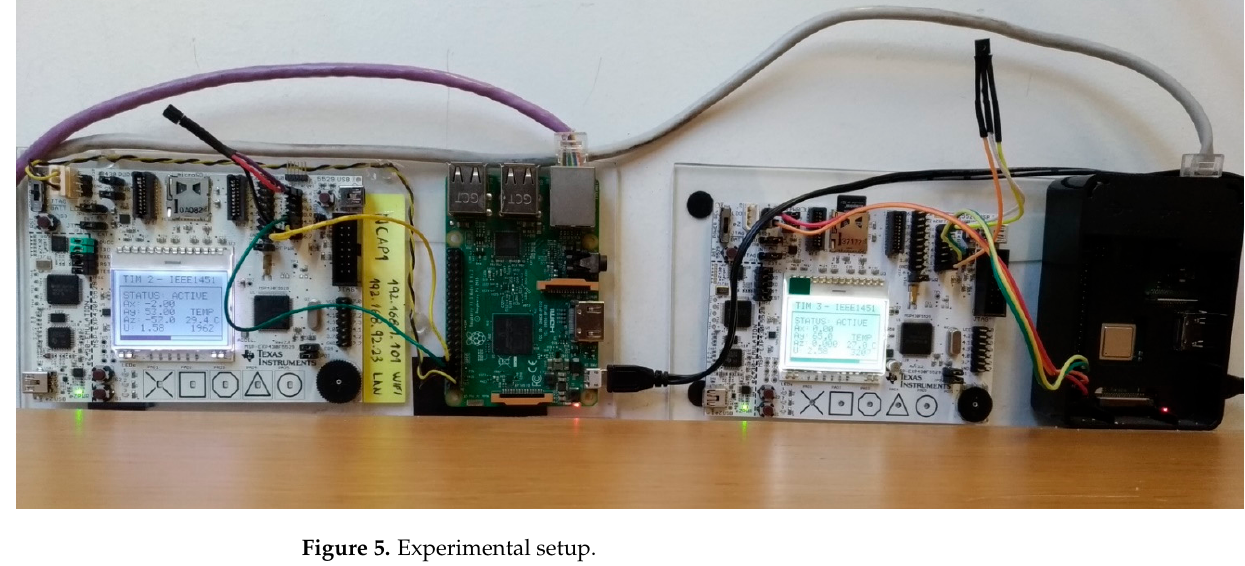
Figure 5. Experimental setup.